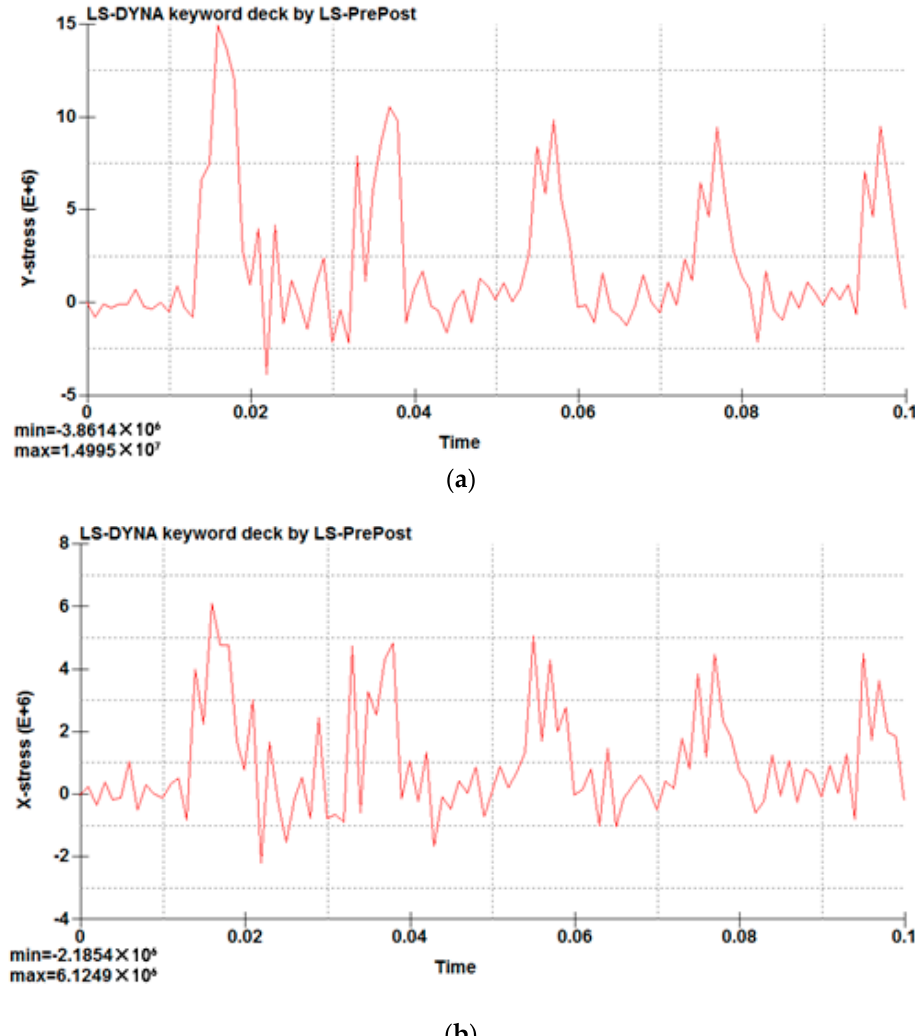
Figure 16. Variation of mid-point stress under 50 Hz. ( a ) longitudinal stress. ( b ) transverse stress.